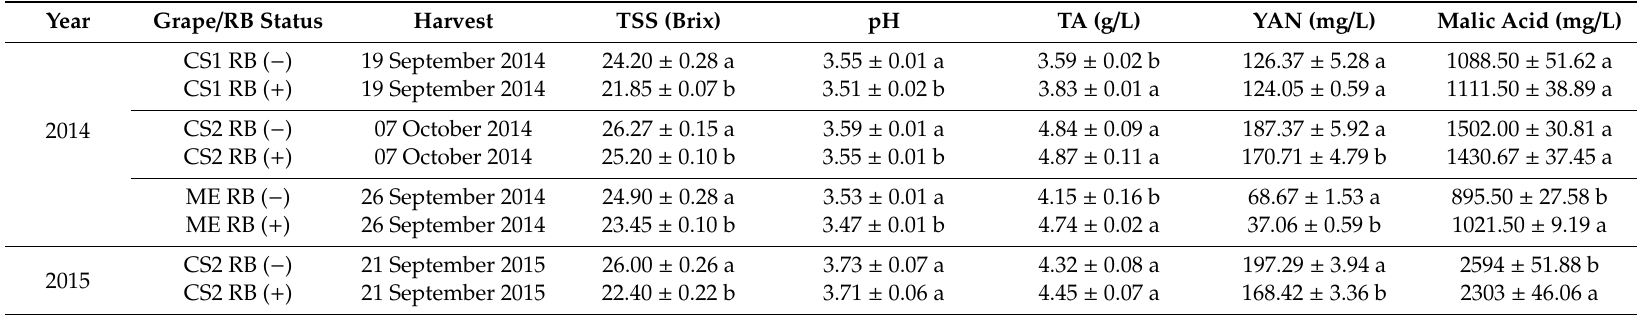
Table 1. Must composition at harvest of RB ( − ) and RB ( + ) wines in 2014 and